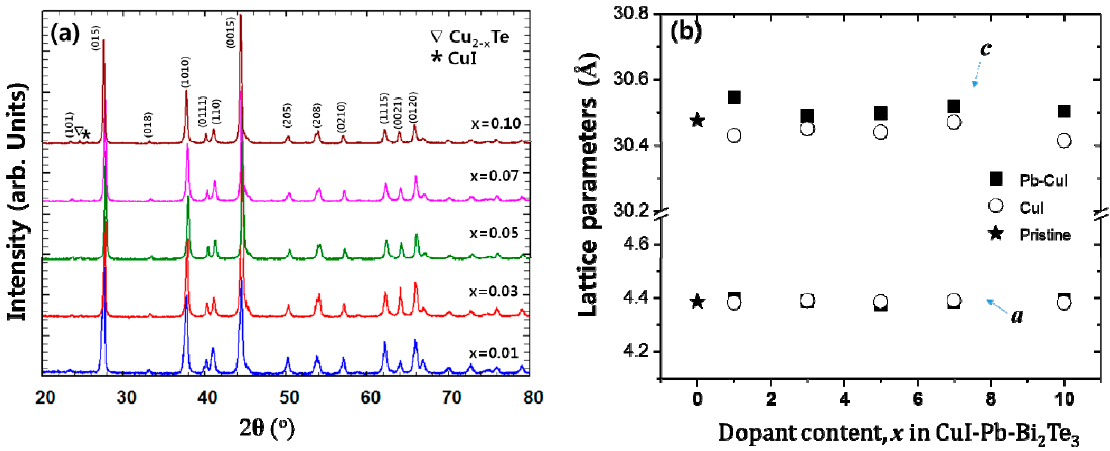
Figure 1. ( a ) Powder X-ray diffraction (XRD) patterns of samples of x % CuI-Pb co-doped Bi 2 Te 3 ( x = 0.01, 0.03, 0.05, 0.07, and 0.10) with peaks of impurity phases (marked by symbols ( ∇ and *)); ( b ) Lattice parameters of samples of x % CuI-Pb co-doped Bi 2 Te 3 ( x = 0, 0.01, 0.03, 0.05, 0.07, and 0.10).